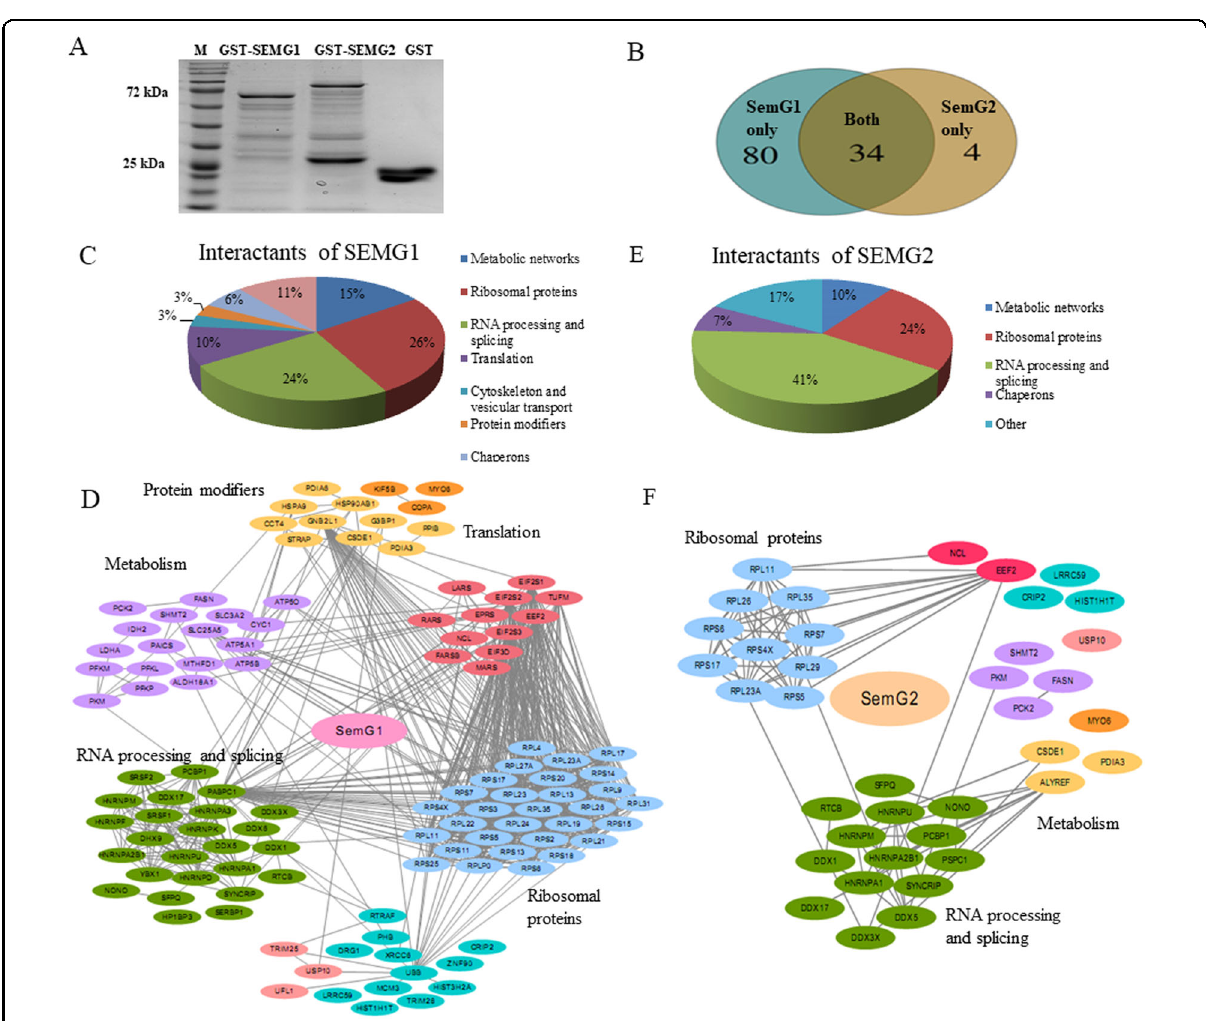
Fig. 3 Identi fi cation of proteins associated with SEMG1 and SEMG2. A Coomasie staining of PAAG after separation of proteins interacted with recombinant SEMG1 and SEMG2. B Overlap of proteins associated with SEMG1 and SEMG2. Distribution by function of proteins associated with SEMG1 ( C , D ) and SEMG2 ( E , F